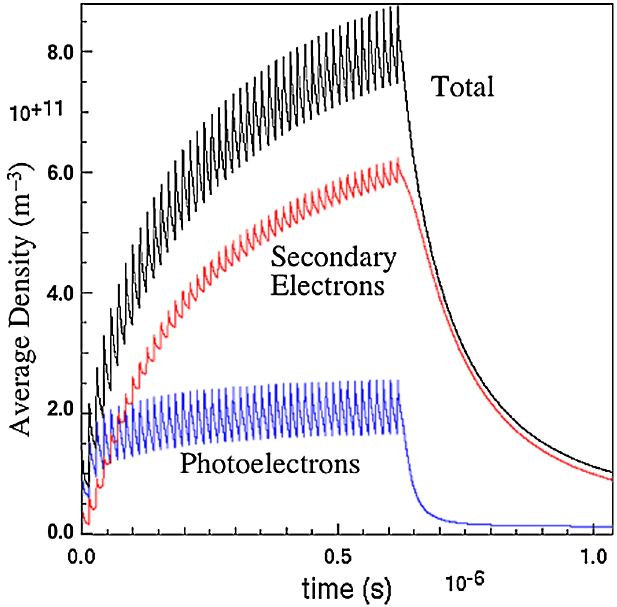
FIG. 2. Buildup of electron density vs time for a 45-bunch train for a z length of 6.24 mm centered at the maximum of B y in the wiggler. Each bunch passage causes a spike in the density.